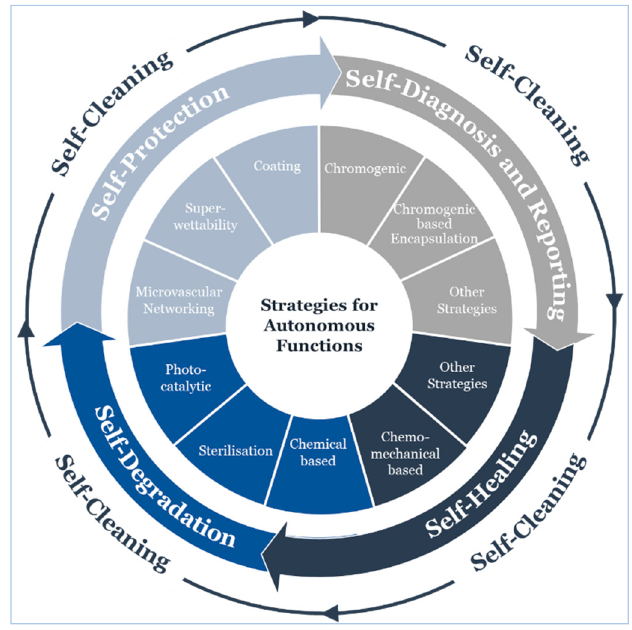
Figure 20. Strategies for autonomous functions throughout the operational lifecycle.